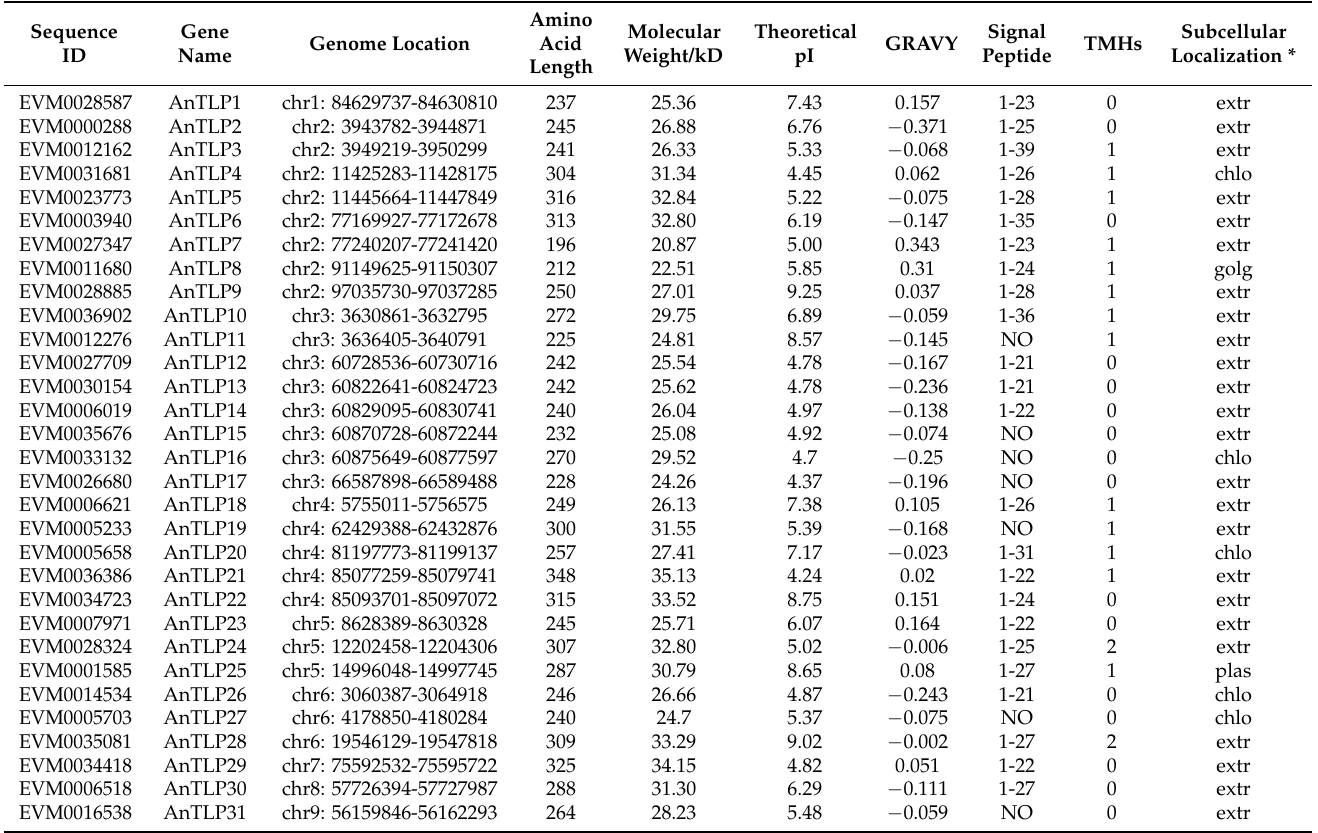
Table 1. Characterization of the predicted TLPs in A. nanus.